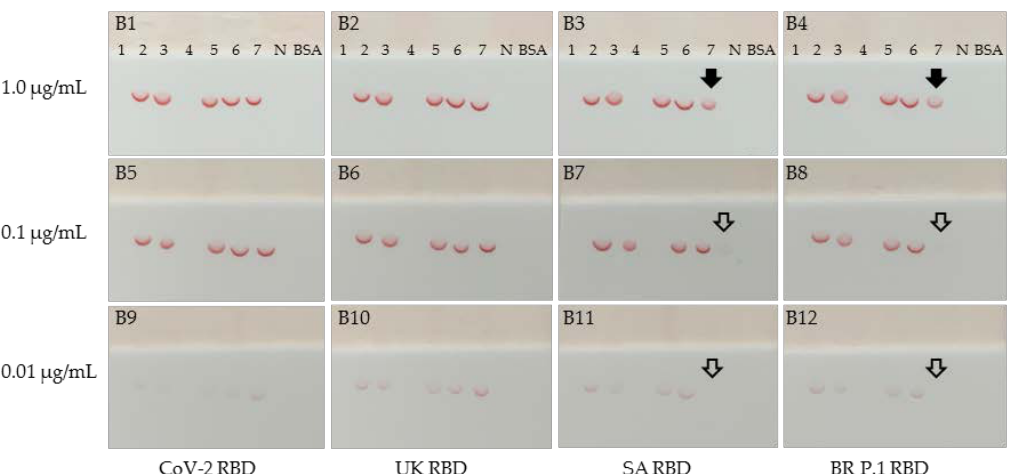
Figure 4. Comparative binding characteristics for four RBDs using Ab4-AuNP and Ab5-AuNP as detectors, with representative photographs of the test results. ( A ) Binding behavior of the Ab5-AuNP conjugate to four RBDs. ( B ) Binding behavior of the Ab4-AuNP conjugate to four RBDs. (Note 1) Solid arrows in the dipsticks ( A11 , A12 , B3 , and B4 ) indicate similar signal intensity at the Ab7 spot. Open arrows in the dipsticks ( B7 , B8 , B11 , and B12 ) indicate very faint or invisible signals at the Ab7 spot. (Note 2) Both the Ab4-AuNP and Ab5-AuNP conjugates were prepared with 20 μg of antibody per mL of 20 OD AuNP solution.